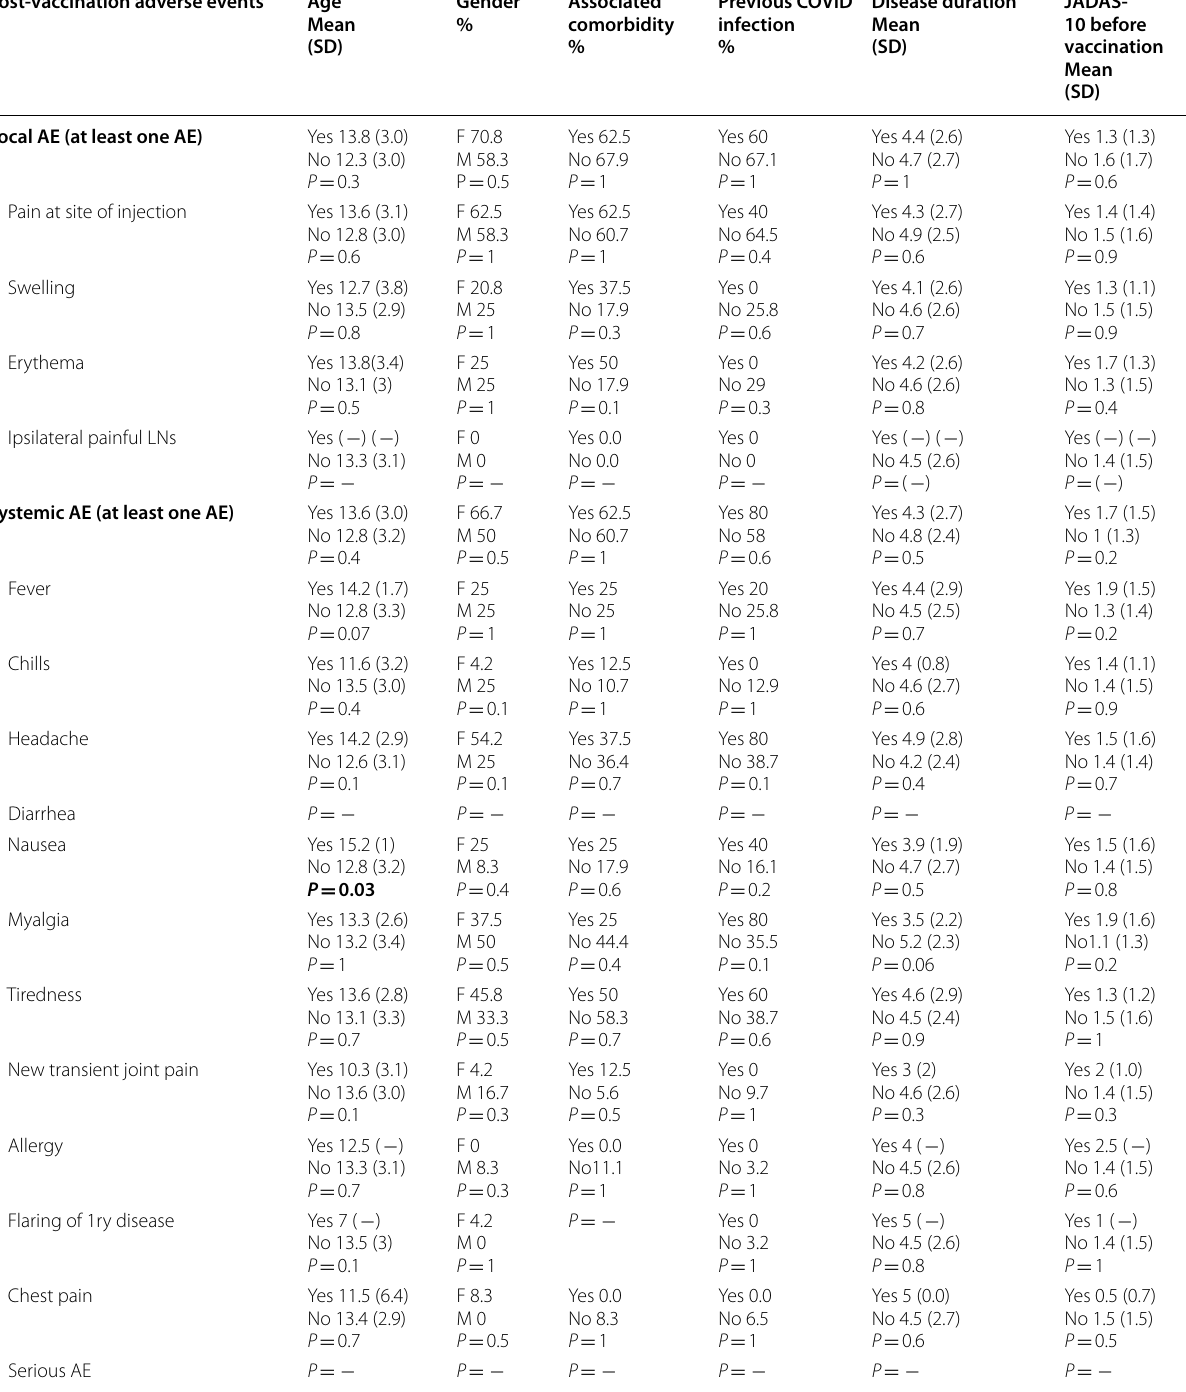
Abbreviations: AE Adverse events, JADAS-10 Juvenile Arthritis Disease Activity Score-10